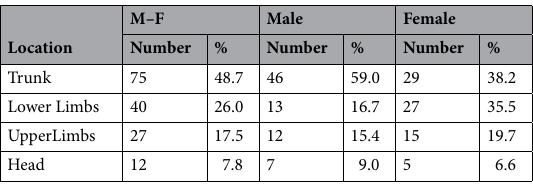
Table 1. Localizations and gender